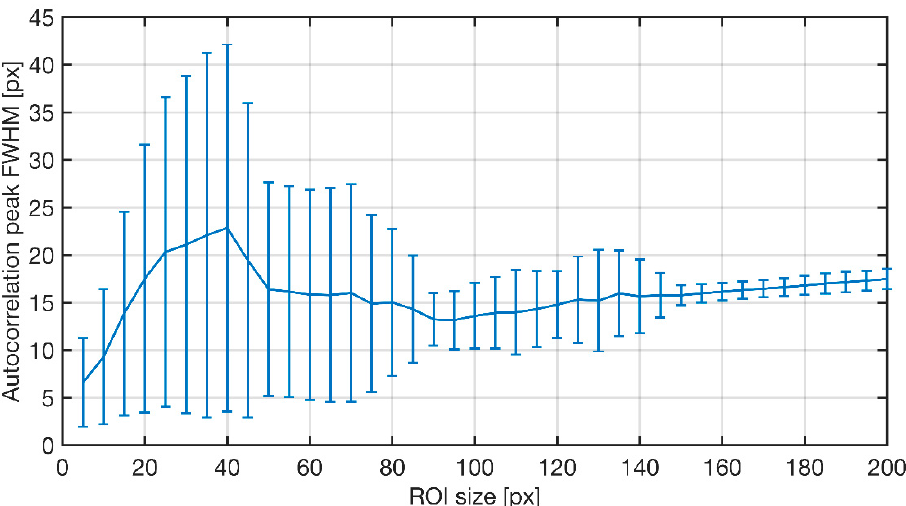
Figure 4. Size of the texture details estimated as the autocorrelation FWHM for the different region of interest (ROI) sizes for sample 1 in the green channel at 50 random positions. The results of other channels and samples showed similar outcomes.